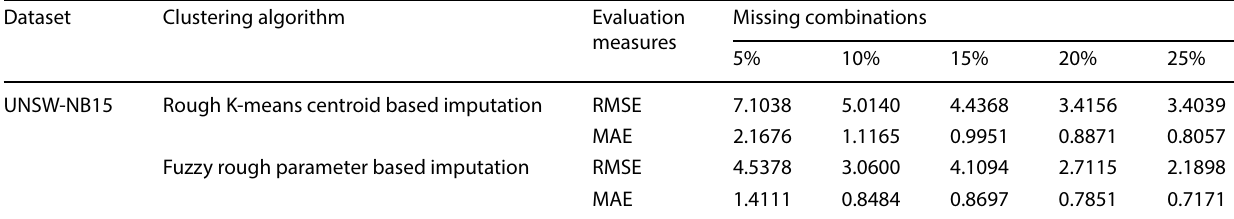
Table 3 RMSE and MAE on UNSW-NB15 dataset